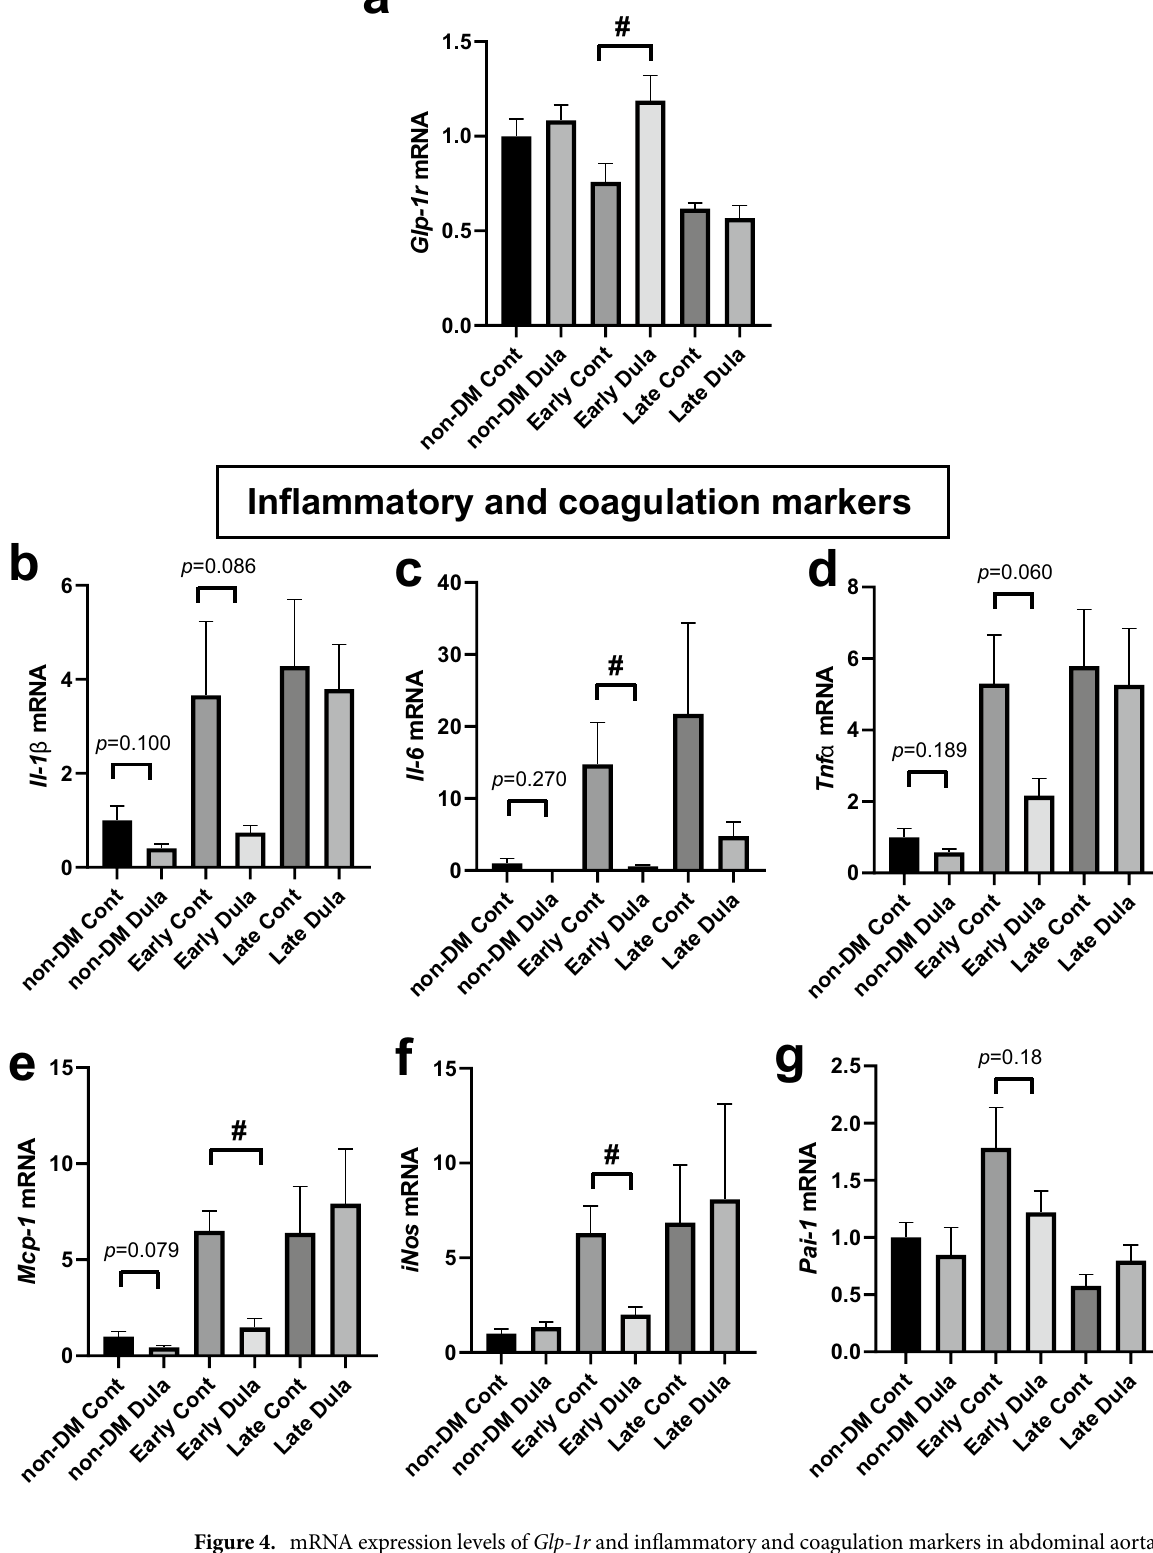
Figure 4. mRNA expression levels of Glp-1r and inflammatory and coagulation markers in abdominal aorta. ( a ) Glp-1r mRNA expression levels, ( b – g ) mRNA expression levels of inflammatory and coagulation markers expressed as fold change relative to non-diabetic control group. Non-diabetic Cont (n = 8), Non-diabetic Dula (n = 8), Early diabetic Cont (n = 8), Early diabetic Dula (n = 6), Late diabetic Cont (n = 8), Late diabetic Dula (n = 7). Values are the mean ± SEM of data obtained from each group. # p < 0.05 (Early Cont vs Early